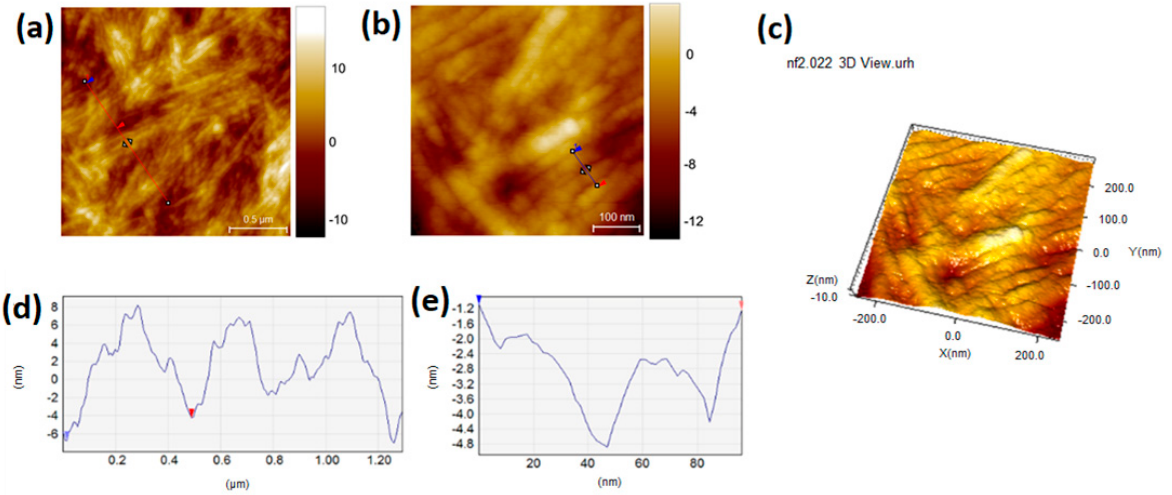
Figure 7. Topographic AFM images (1.5 × 1.5 μ m 2 ( a ), 0.6 × 0.6 μ m 2 ( b ) and 3D ( c )) of Somatuline Autogel ® ( d , e ). Graphs showing the height line profiles measured on the topographies indicated by the blue lines. AFM images show the presence of tubular structures that self-organized in ribbons. Graphs display the height and width of ribbons ( d ) and tubular structures ( e ). AFM measurements were performed in tapping mode on dry samples.